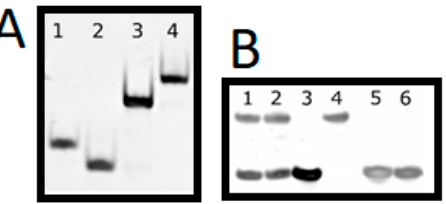
Figure 5. ( A )—Native polyacrylamide gel electrophoresis (PAGE) of biomolecules. Lane: (1)— ssDNA* A, (2)—ssDNA B, (3)—dsDNA, (4)—dsDNA*-PEP. ( B )—Denaturing PAGE of biomolecules. Lane: (1)—dsDNA**-PEP, (2)—dsDNA*-PEP, (3)—dsDNA, (4)—ssDNA*-PEP, (5)—ssDNA B, (6)— ssDNA* A. PAGE conditions: 15% PAGE with or without 7M urea; 150 V for 1 or 1.5 h for native and denaturating PAGE, respectively, stained with